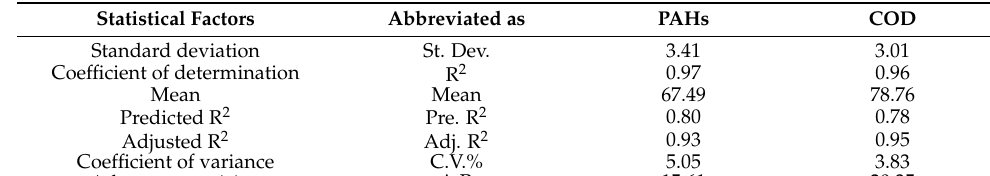
Table 4. RSM model fit summary output table for PAHs and COD.